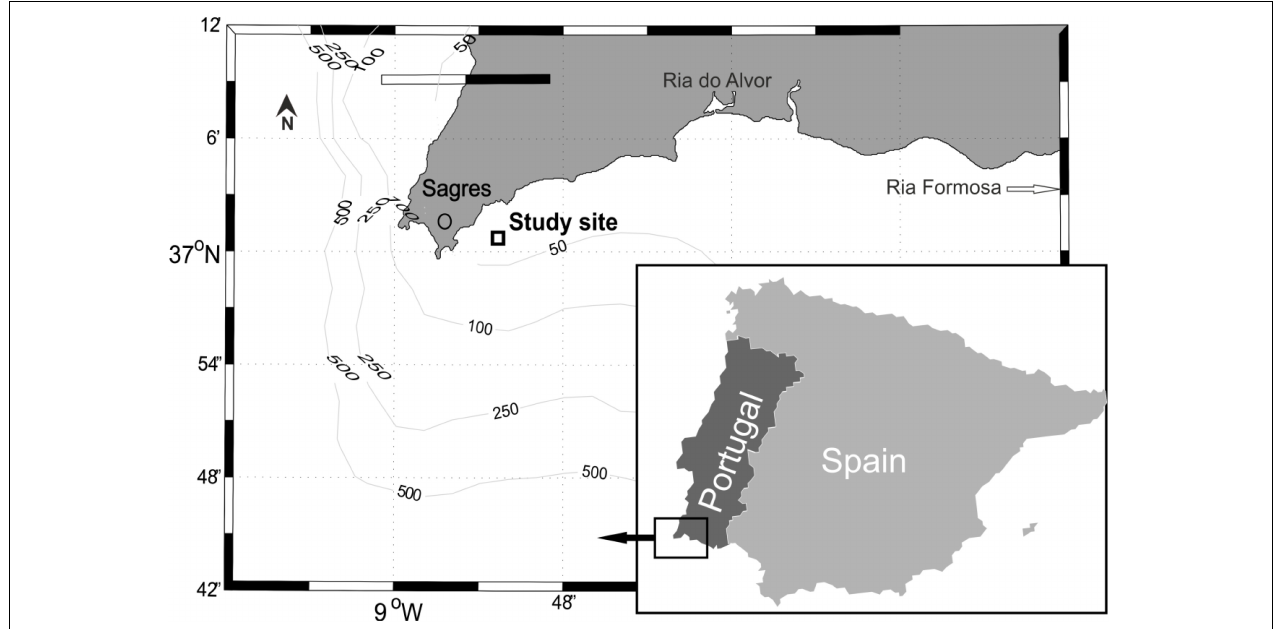
FIGURE 1 | Study site location shown on the higher scale map off Sagres in the vicinity of Cape Saint Vincent, South-West Portugal. Aquaculture areas Ria do Alvor and Ria Formosa are shown to the east of the main study site.